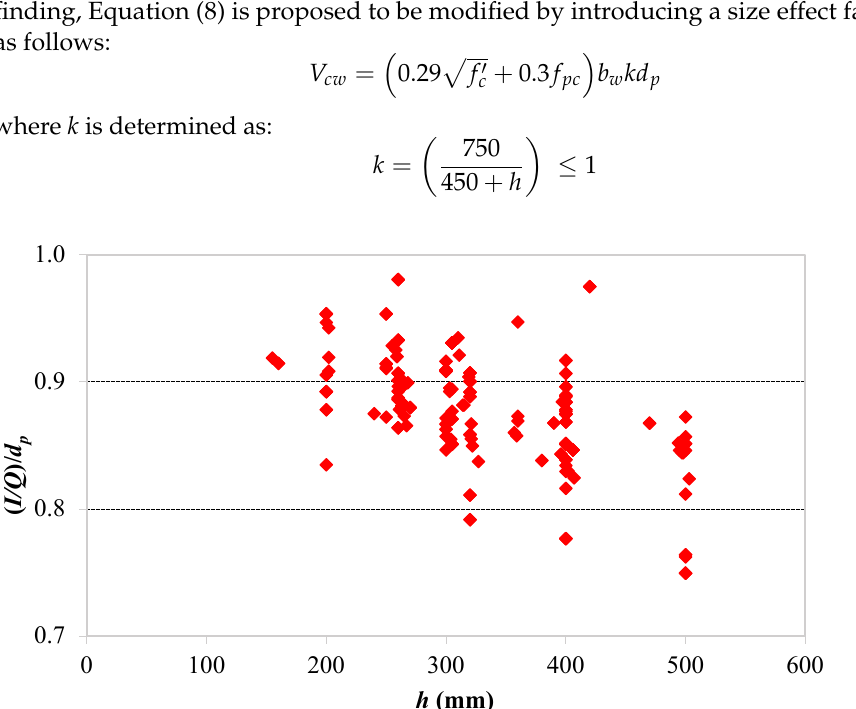
Figure 11. Variation of the ( I / Q )/ d p ratio with slab thickness.